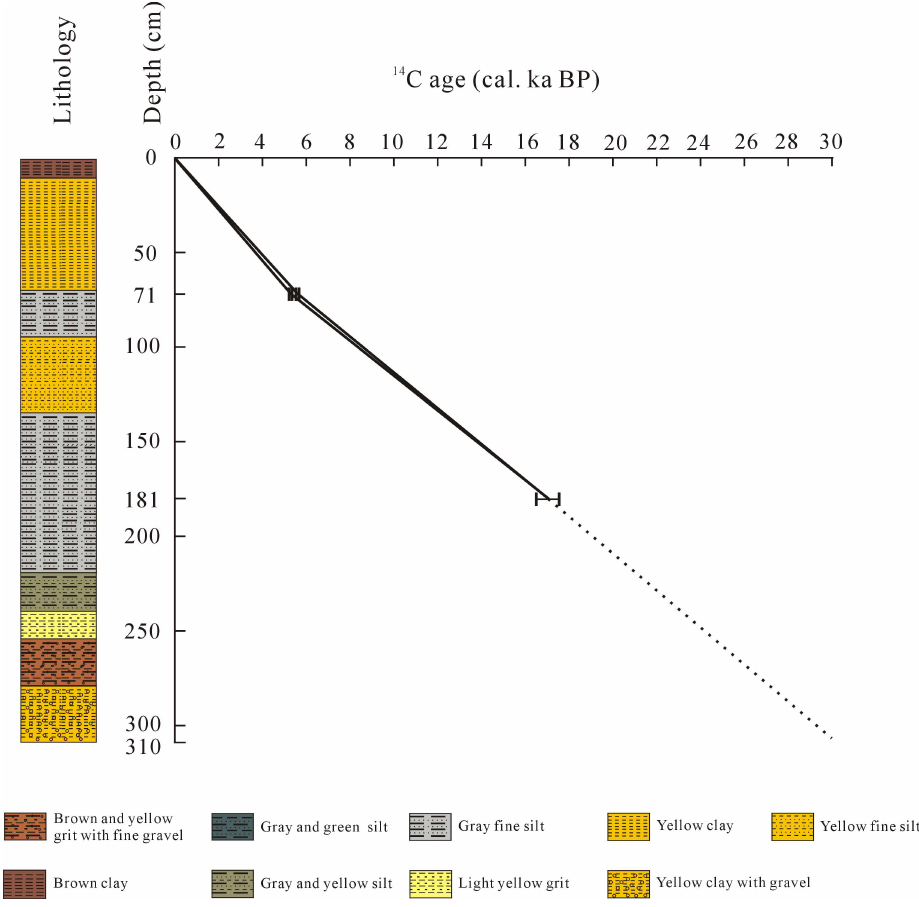
Fig 2. Lithology of the Shudu Lake core and age-depth curve showing rate of sedimentation.